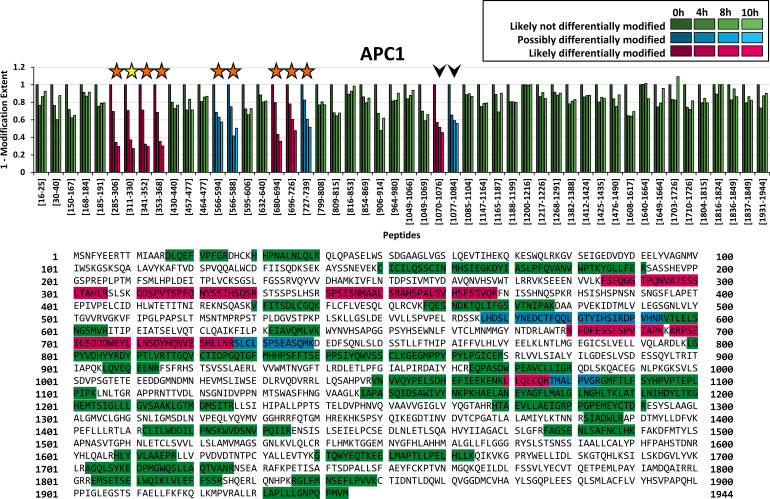
Application of FLEXIQuant-LF to remaining APC/C core components.Peptide classification and extent of modification of APC1. Seven out of 50 quantified peptides were classified as likely differentially modified and four peptides as possibly differentially modified. We found evidence of modification for six out of seven peptides classified as likely differentially modified (five in our DDA data and six described in the literature) as well as for three out of four peptides classified as possibly differentially modified in our DDA data (see also Table 1). Additionally, two peptides were classified as likely differentially modified and possibly differentially modified (indicated by arrow heads) but no evidence of modification was found in literature. Interestingly, these two peptides are consecutive, and the second peptide starts with threonine (AA 1077). An as of now undiscovered threonine modification such as a phosphorylation would likely lead to a highly increased missed cleavage rate and could explain the reduction of the signal intensities of both peptides. Classification and extent of modification of the remaining APC/C core components is shown in Figure 3—figure supplements 1 and 2.